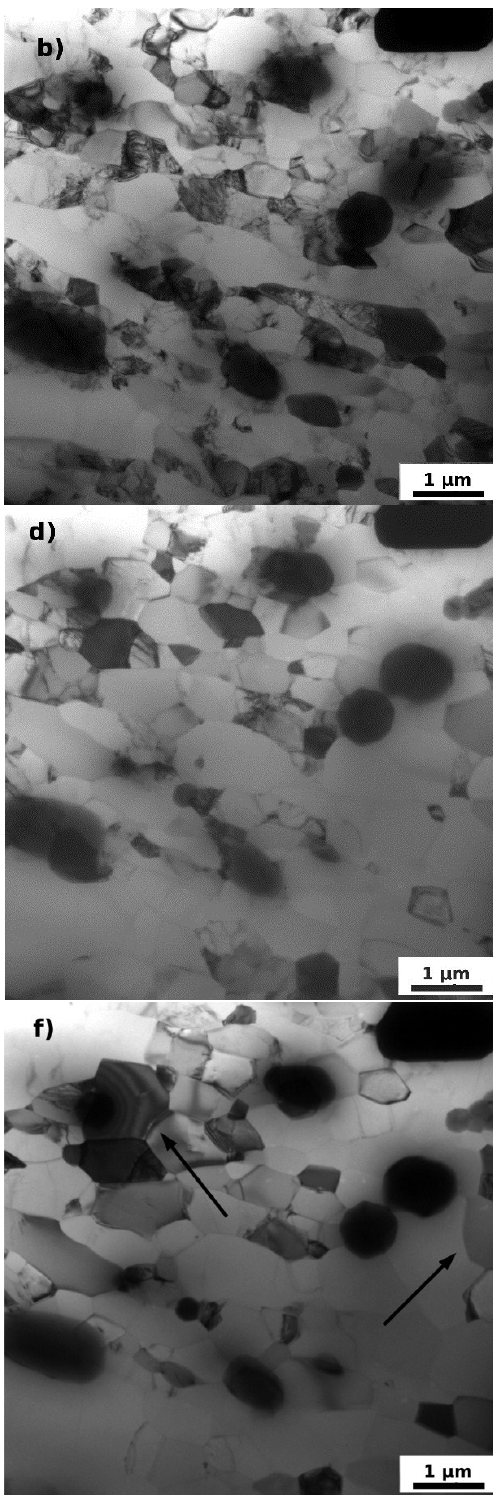
Figure 8. TEM micrographs of F3 material ( a ) after ARB processing; and annealing up to ( b ) 150 °C; ( c ) 200 °C; ( d ) 250 °C; ( e ) 300 °C; and ( f ) 350 °C. Images show the same area in the specimen in situ annealed inside the electron